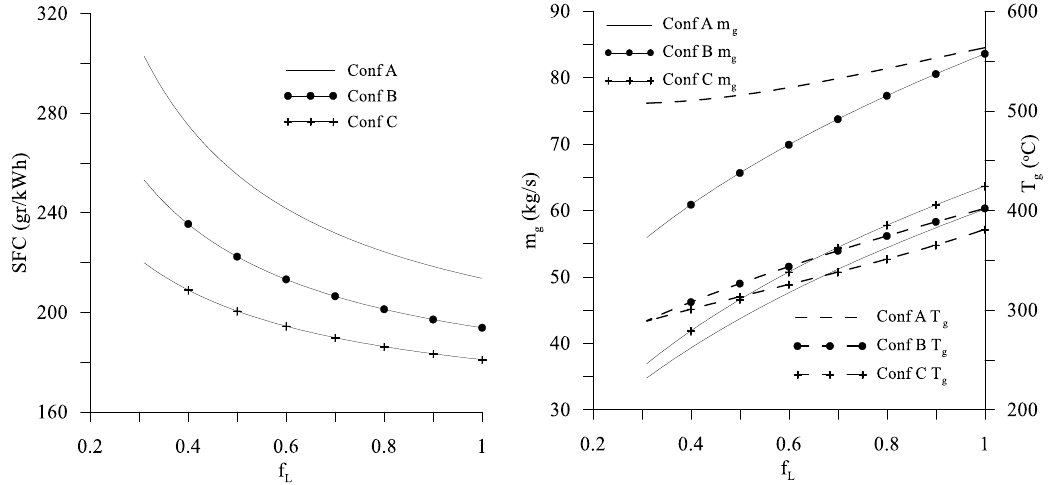
Figure 5. Variation of specific fuel consumption (SFC) and exhaust gas characteristics in partial load operation (fuel MDO).